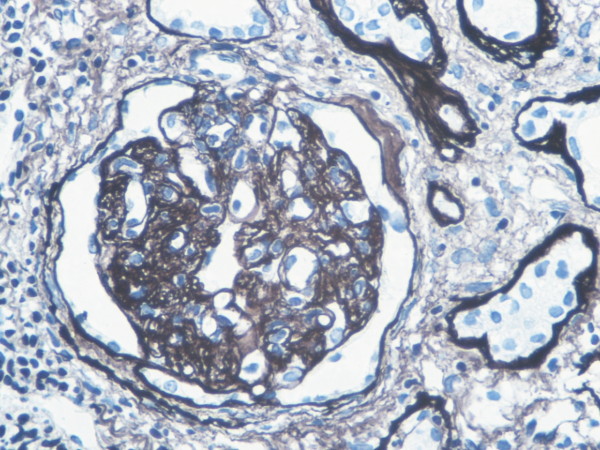
Expression of C4d and renal histology. Glomerular double contours (original magnification × 400).